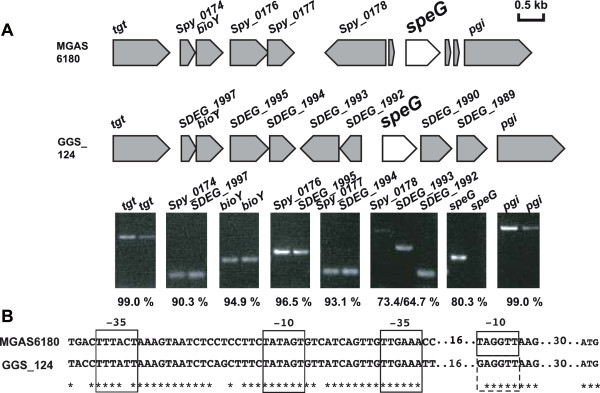
Expression of genes surrounding speG. (A) RT-PCR analysis of the expression of the eight or nine genes surrounding speG in GGS_124 (SDSE) and MGAS6180 (GAS). The amino acid identity of each gene (%) in these two strains is indicated below each gene. (B) Putative predicted promoter regions at -10 bp and -35 bp of speG in GGS_124 and MGAS6180. The mutation in the putative -10 bp region in GGS_124 made it no longer a putative promoter region; it is therefore enclosed in a dotted line box.